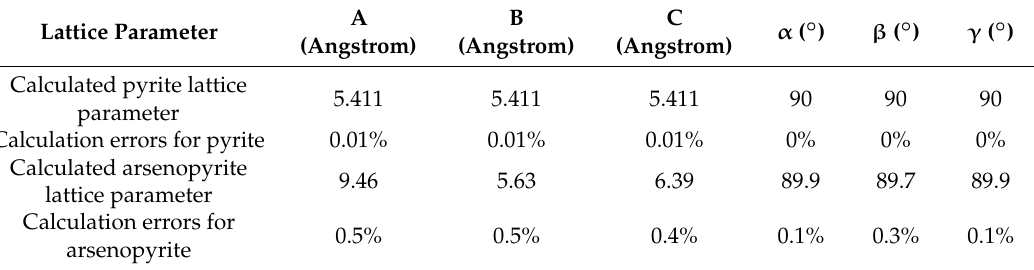
Table 4. Calculation errors for pyrite and